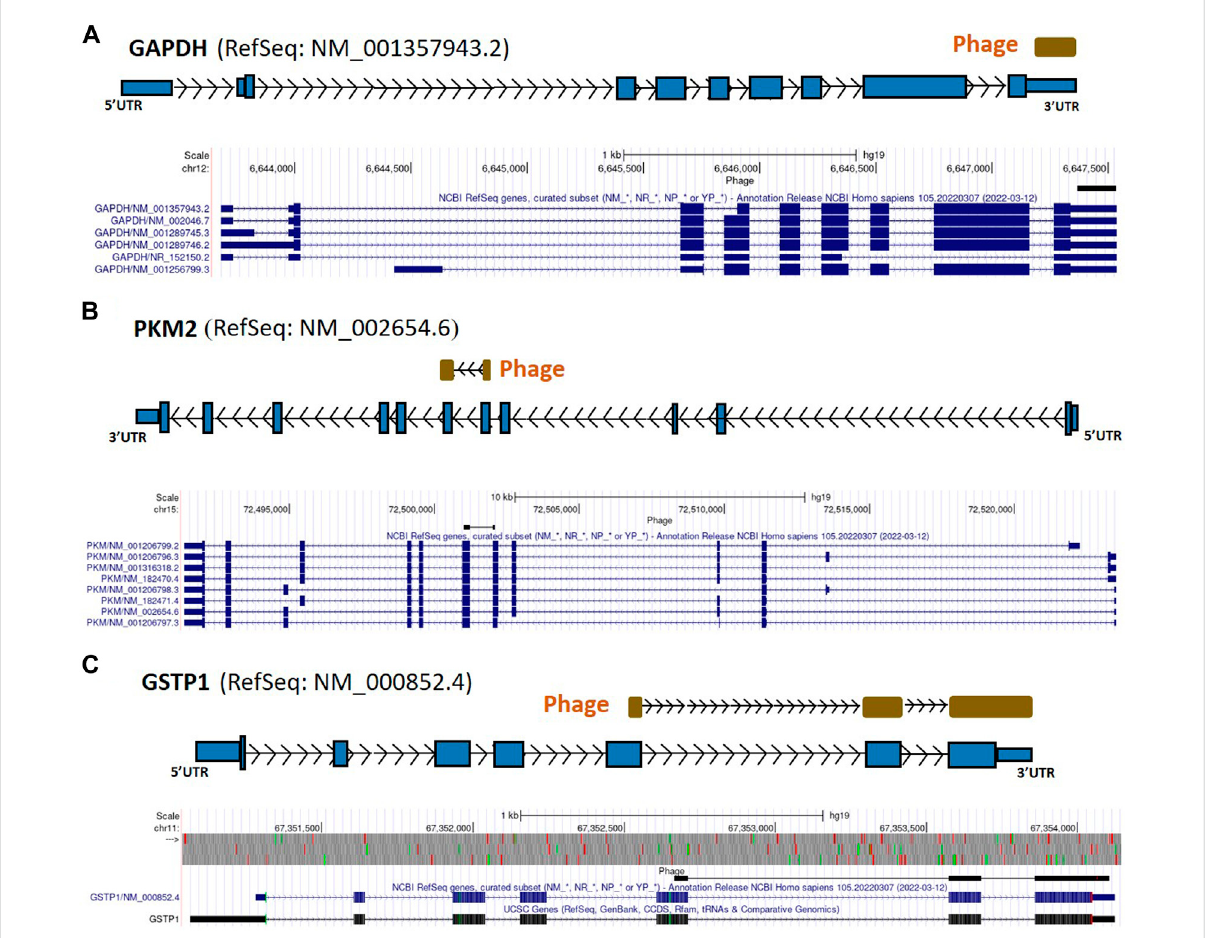
FIGURE 2 GAPDH , PKM2, and GSTP1 gene regions as autoreactive BC antigens identi fi ed by UCSC Genome Browser BLAT mapping and annotation of uniquely patient-sera-reactive phages. (A) Identi fi ed phage mapped completely within the 3 ′ -UTR region of GAPDH gene. (B) Identi fi ed phage mappedtotheprotein-codingregionof PKM2 . (C) Identi fi edphagemappedtotheprotein-codingregionaswellas3 ′ -UTRregionof GSTP1 . GAPDH , glyceraldehyde 3-phosphate dehydrogenase; PKM2 , pyruvate kinase isoenzyme M2; GSTP1 , glutathione S-transferase Pi 1; UTR, untranslated region; kb, kilobase, EST, expressed sequence